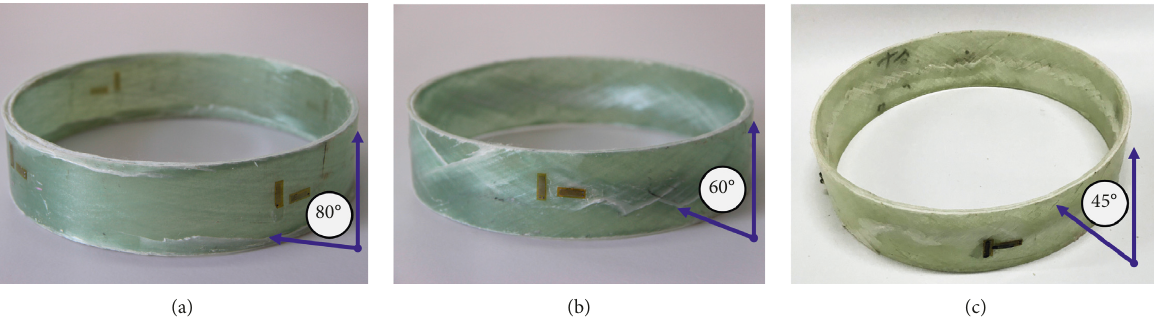
Figure 7: FRP short tubes after axial compression. (a) ± 80 ° . (b) ± 60 ° . (c) ± 45 ° .